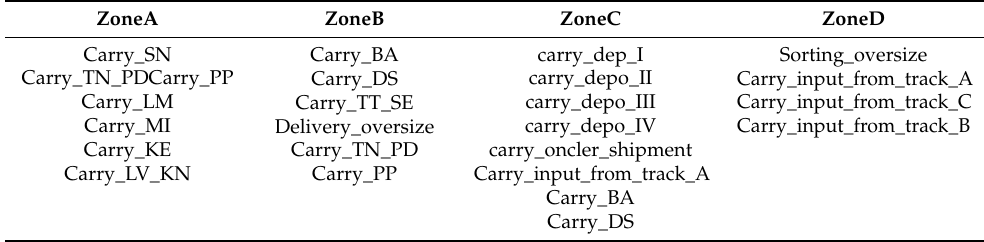
Table 1. Range of activities in different zones.